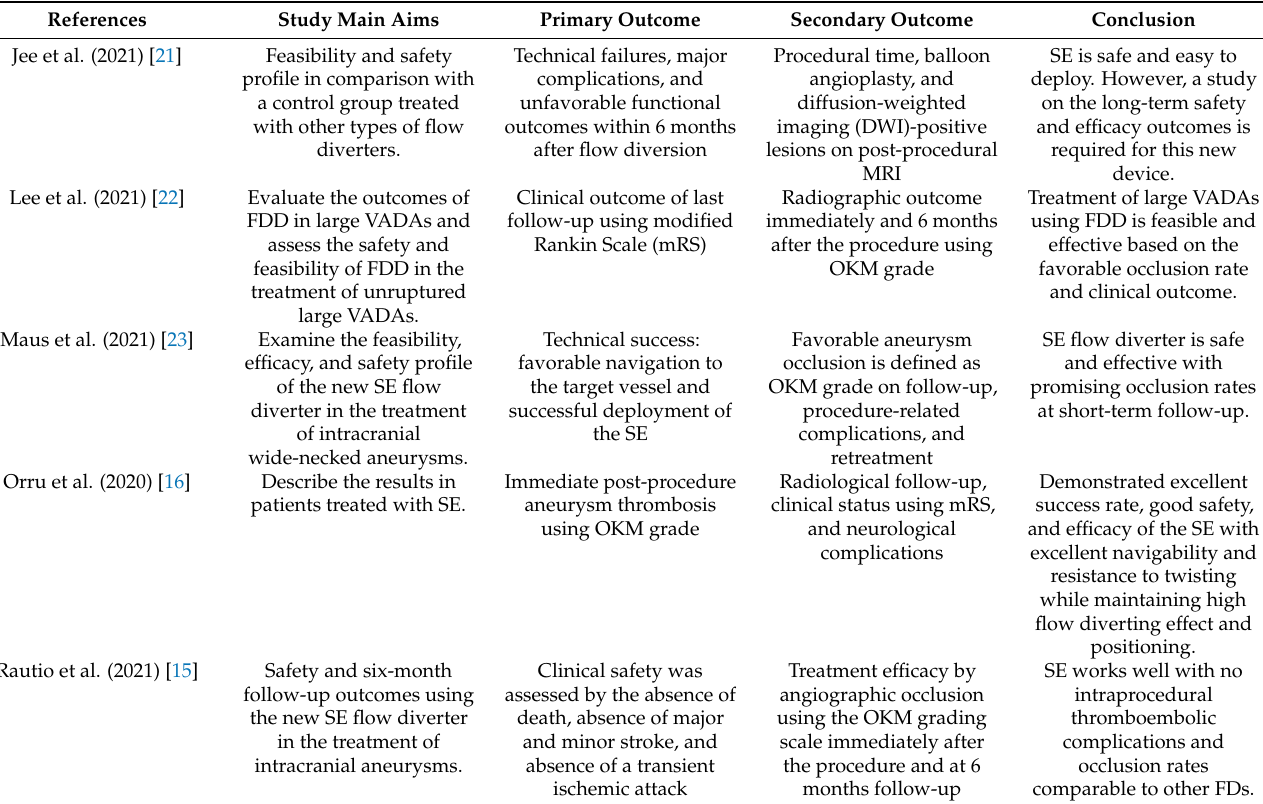
Table 3. Included studies aims, outcomes, and